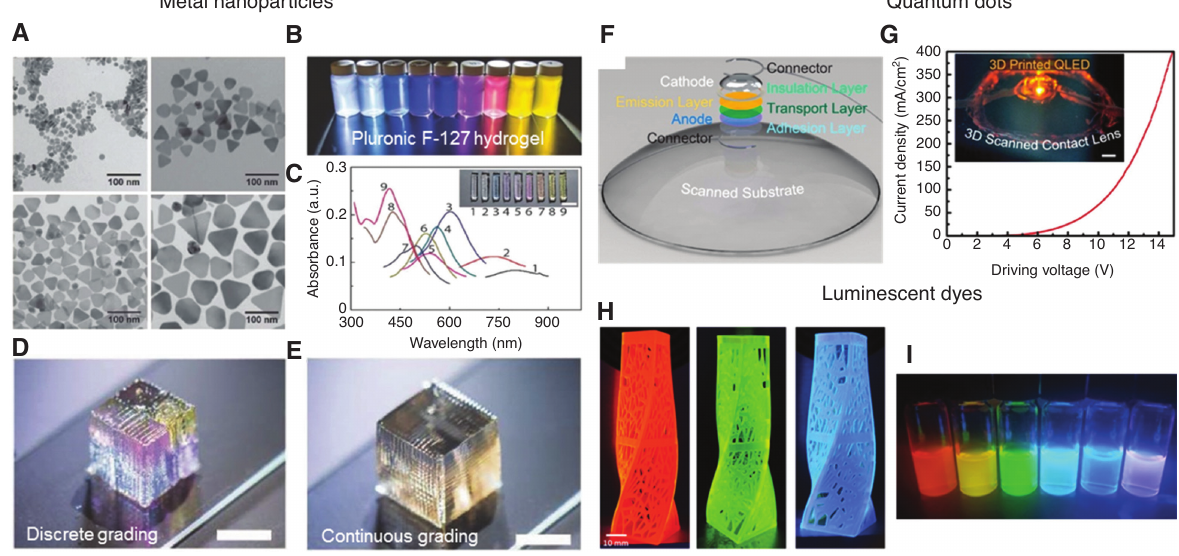
Figure 2: 3D printing with functional nanomaterials. (A) TEM images of different sizes (15, 39, 58, 79 nm) of silver nanoprisms. (B) Photograph of Pluronic F-127 plasmonic inks with